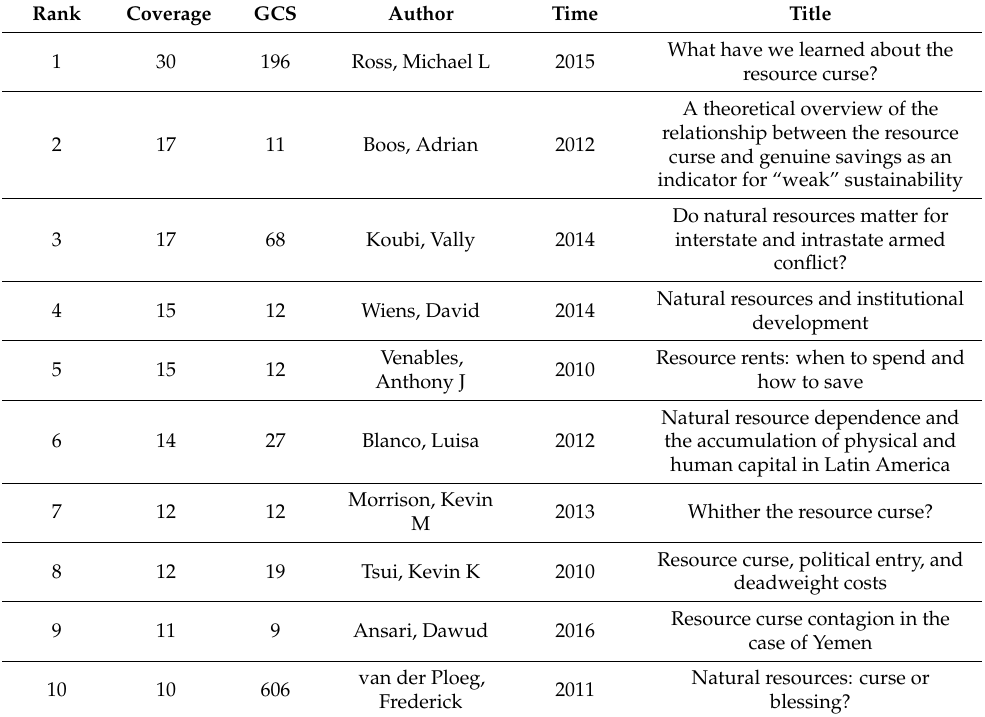
Table A4. Citing articles in Cluster